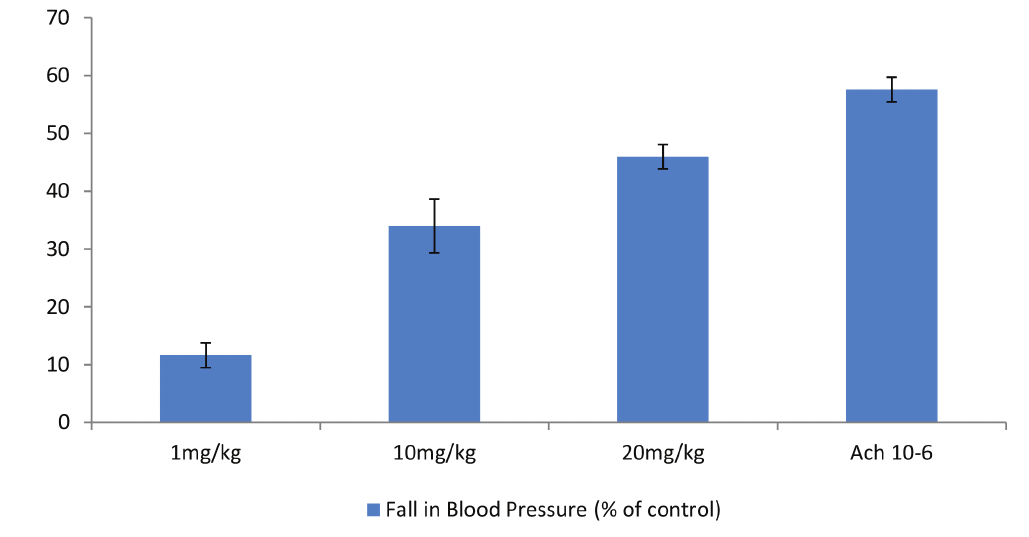
FIGURE 1 - Hypotensive activity of BRBD in normotensive